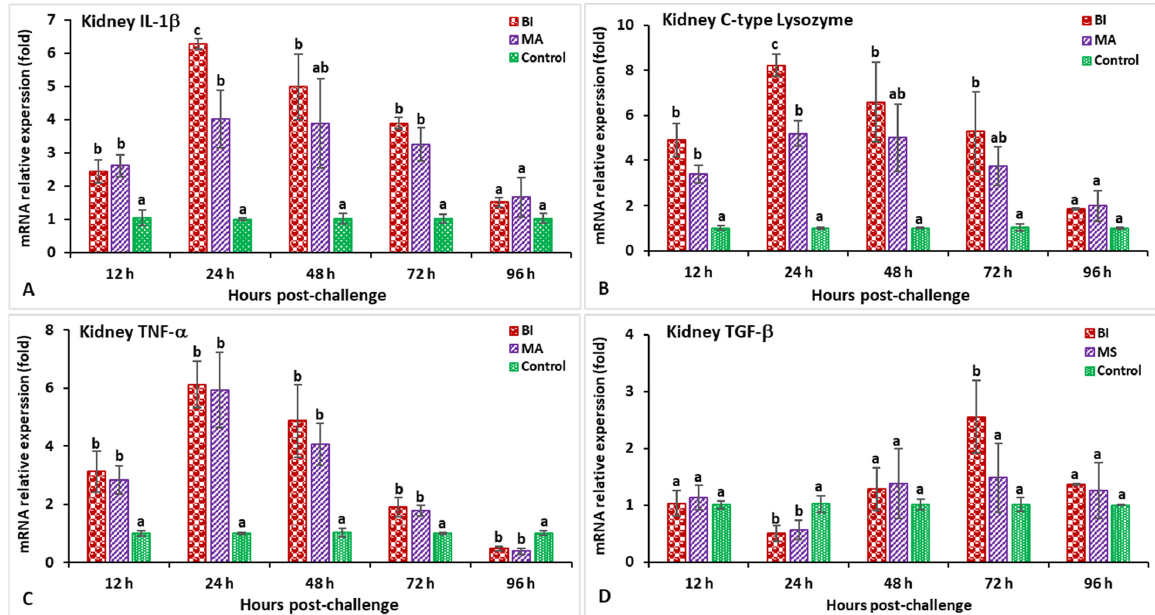
Figure 11. The gene expression of IL-1 β ( A ), C-type lysozyme ( B ), TNF- α ( C ), and TGF- β ( D ) in the head kidneys of orally vaccinated fish after being challenged by Aeromonas hydrophila . Samples were analyzed in triplicate (3 pools, 2 fish head kidneys/pool) and shown as the mean ± SE. Dissimilar letters denote significant differences ( p < 0.05).